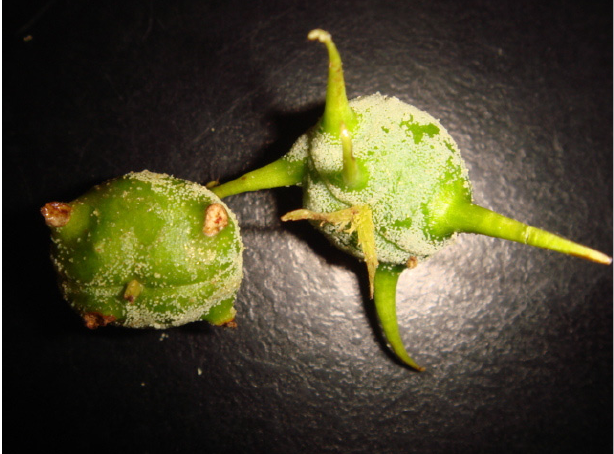
Figure 1. New (right) and mature (left) fruit of M . tanarius